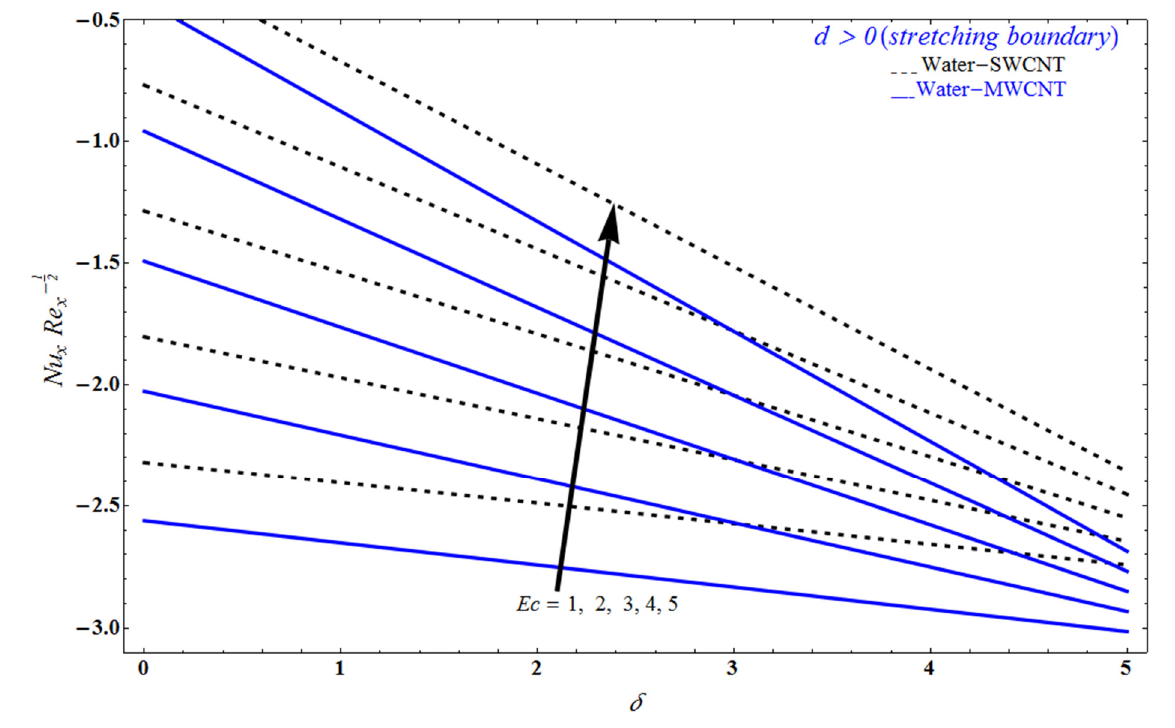
− 1/2 1/2 Re δ on δ for several values of Ec , on for several values of Ec , respectively. Figure 16. Impact of Nu x Re x x x